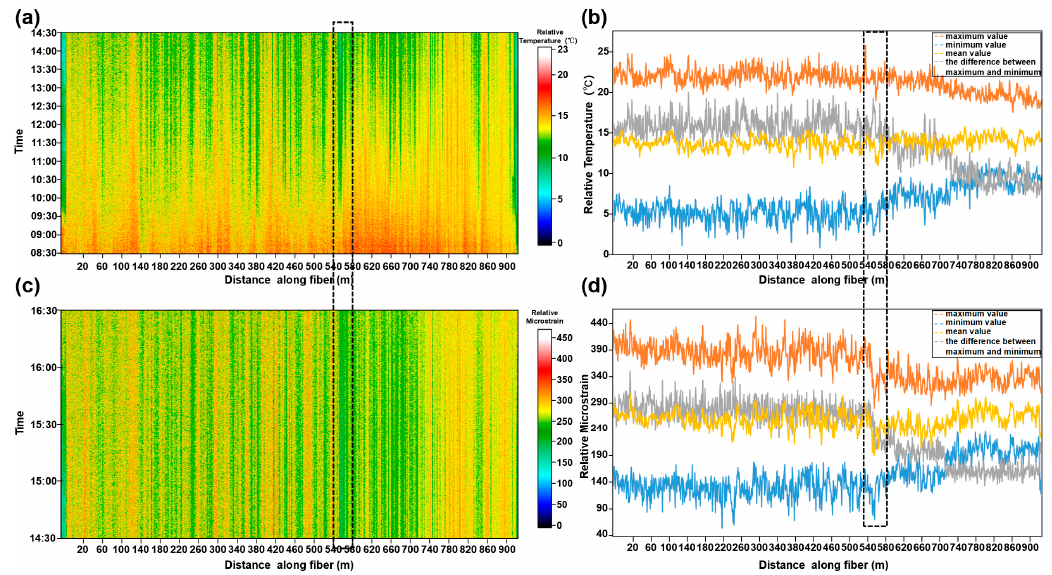
Figure 11. Monitoring results of BOTDR and DTS. ( a ) and ( c ) show the variation in the relative temperature and microstrain of the land surface; the color bars are the relative temperature and the relative microstrain value, respectively. ( b ) and ( d ) are the maximum temperature/microstrain, minimum temperature/strain, mean temperature/strain and the difference between the maximum and minimum values at different positions of the optical fiber during the measurement time. The location shown in the black dashed box is the area with the largest value change, and also the location of shallow active fault.